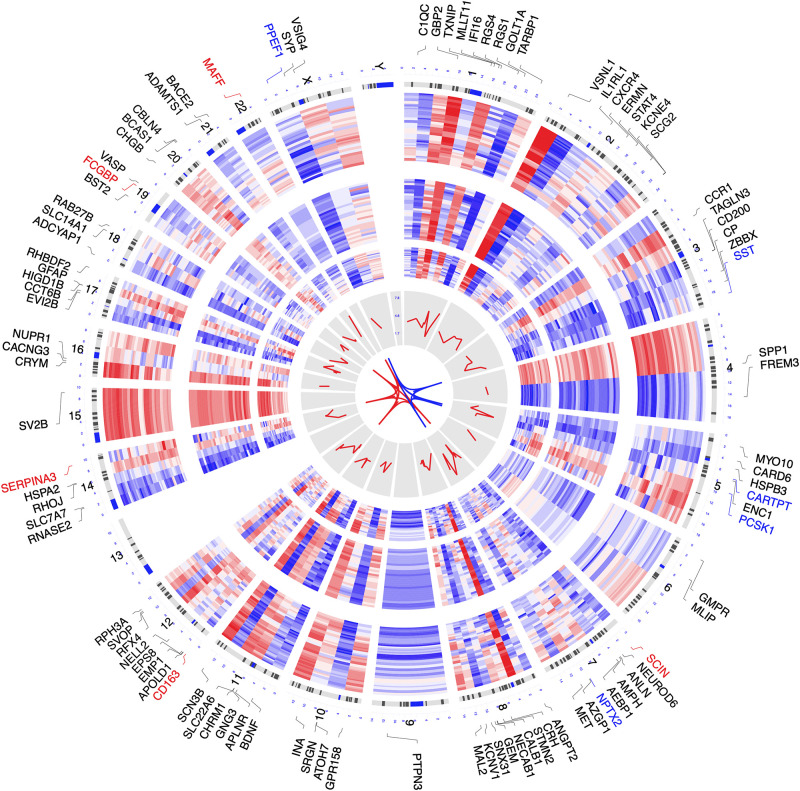
Circos plot of expression patterns and chromosomal positions of top 100 differentially expressed genes (DEGs). The outer circle represents chromosomes, and lines coming from each gene point to their specific chromosomal locations. The three Alzheimer disease (AD) microarray datasets from Gene Expression Omnibus (GEO) used for combined analysis are represented in the inner circular heatmaps. GSE122063, GSE36980, and GSE5281 are presented from the outside to the inside. The red lines in the inner layer indicate -log10 (adjusted P-value) of each gene. According to |log2 fold change|, the top five up-regulated genes (red) and the top five down-regulated genes (blue) are connected with red and blue lines in the center of the Circos plot.